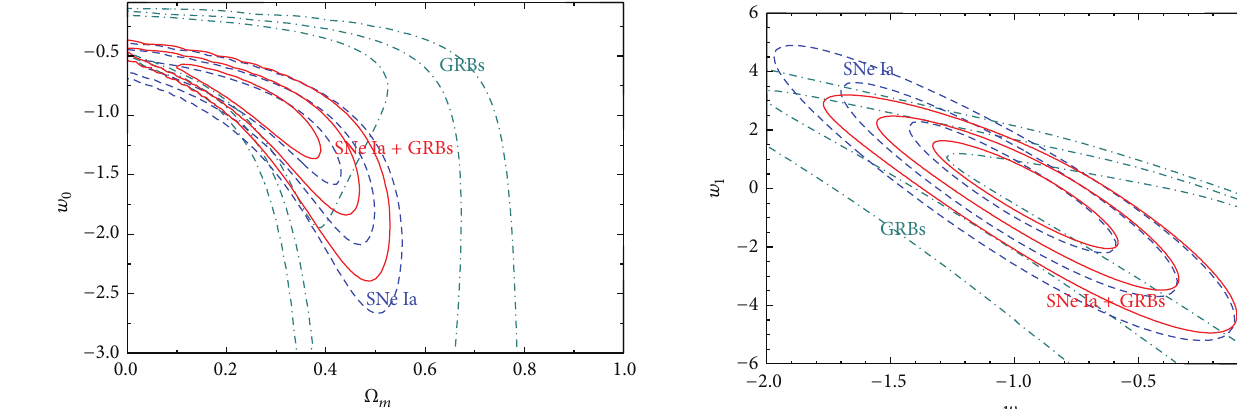
Figure 6: Constraints on 𝑤 0 and 𝑤 1 from 1𝜎 to 3𝜎 confidence regions with dark energy whose equation state is 𝑤(𝑧) = 𝑤 0 + 𝑧/(1 + 𝑧) . The contours are derived from GRBs (dark cyan dash- 𝑤 1 dotted lines), SNe Ia (blue dashed lines), and SNe Ia + GRBs (red solid lines),